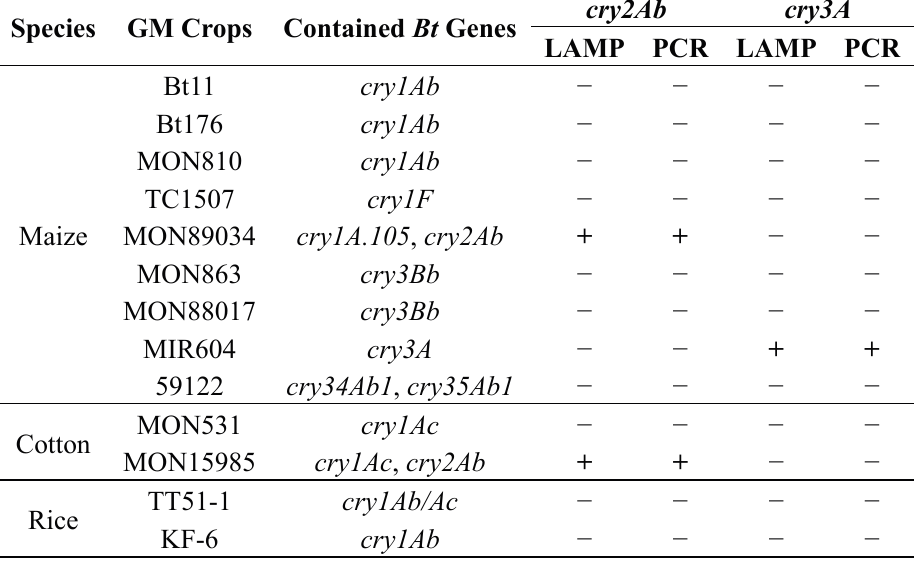
Table 2. The prospective results of LAMP and conventional PCR detecting the cry2Ab and cry3A genes in GM crops with different Bt genes α